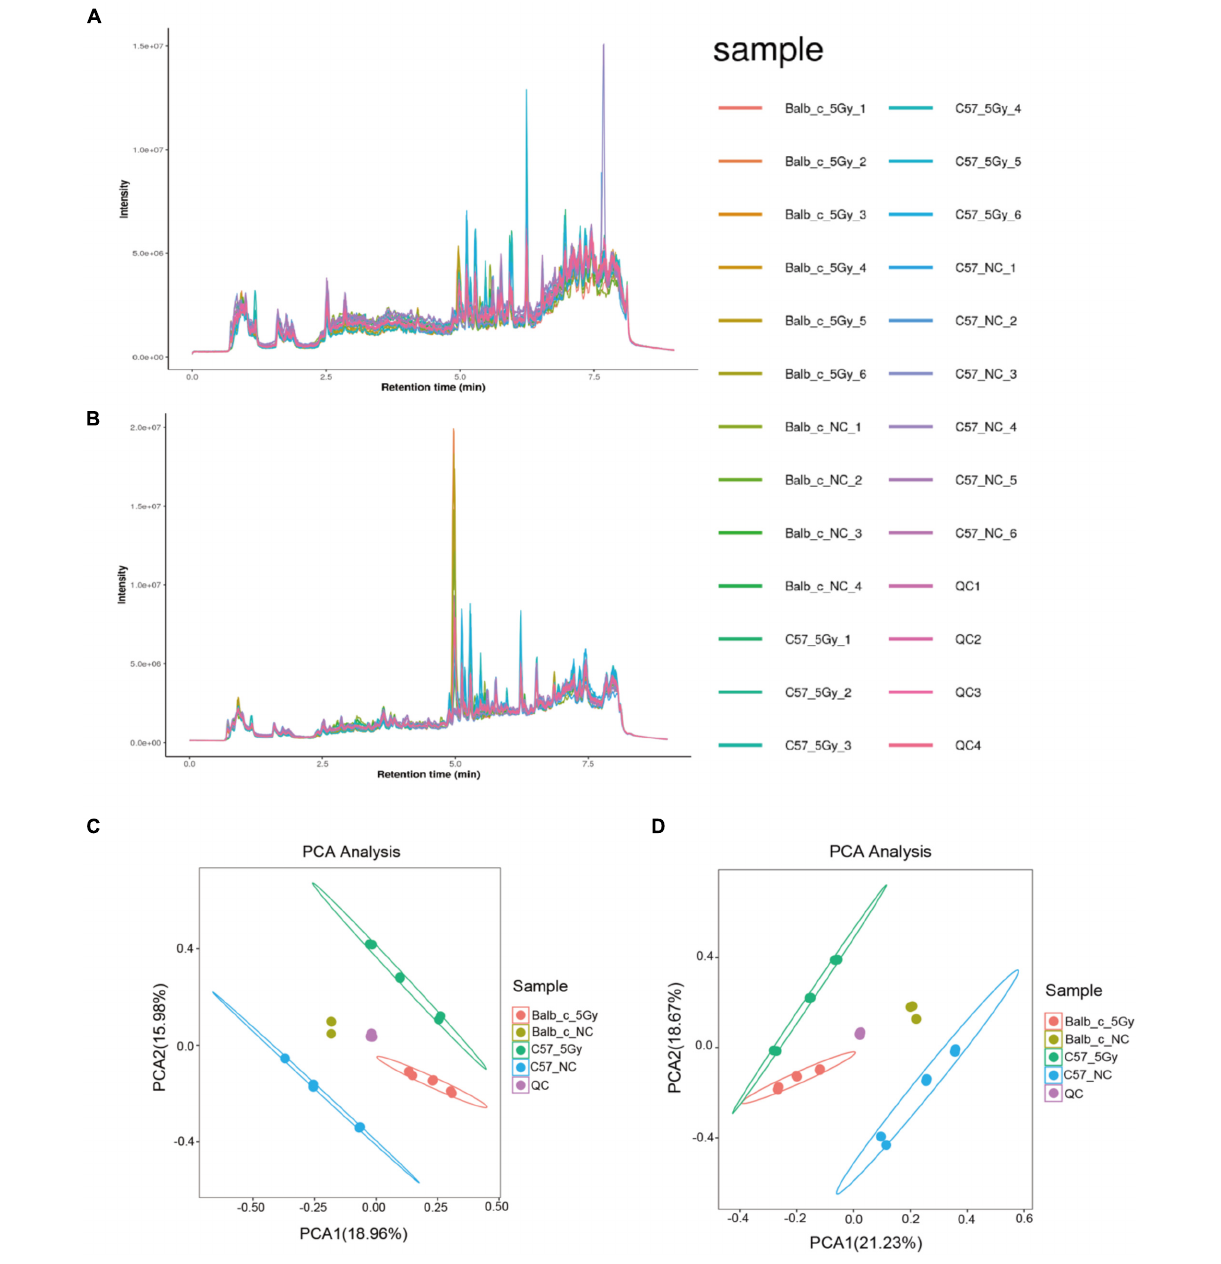
FIGURE 4 | Metabolite detection quality control. Total Ion Chromatogram (TIC): overall control of the overall mass spectrum signal intensity of the sample. TIC can macroscopically reflect the separation of all metabolites in the liquid phase spectrum. (A,C) TIC of positive and negative. (B,D) PCA analysis of the identified metabolic ion. (Balb/c-NC: n = 3; Balb/c-5Gy: n = 6; C57BL/6J-NC: n = 6; C57BL/6J-5Gy: n =